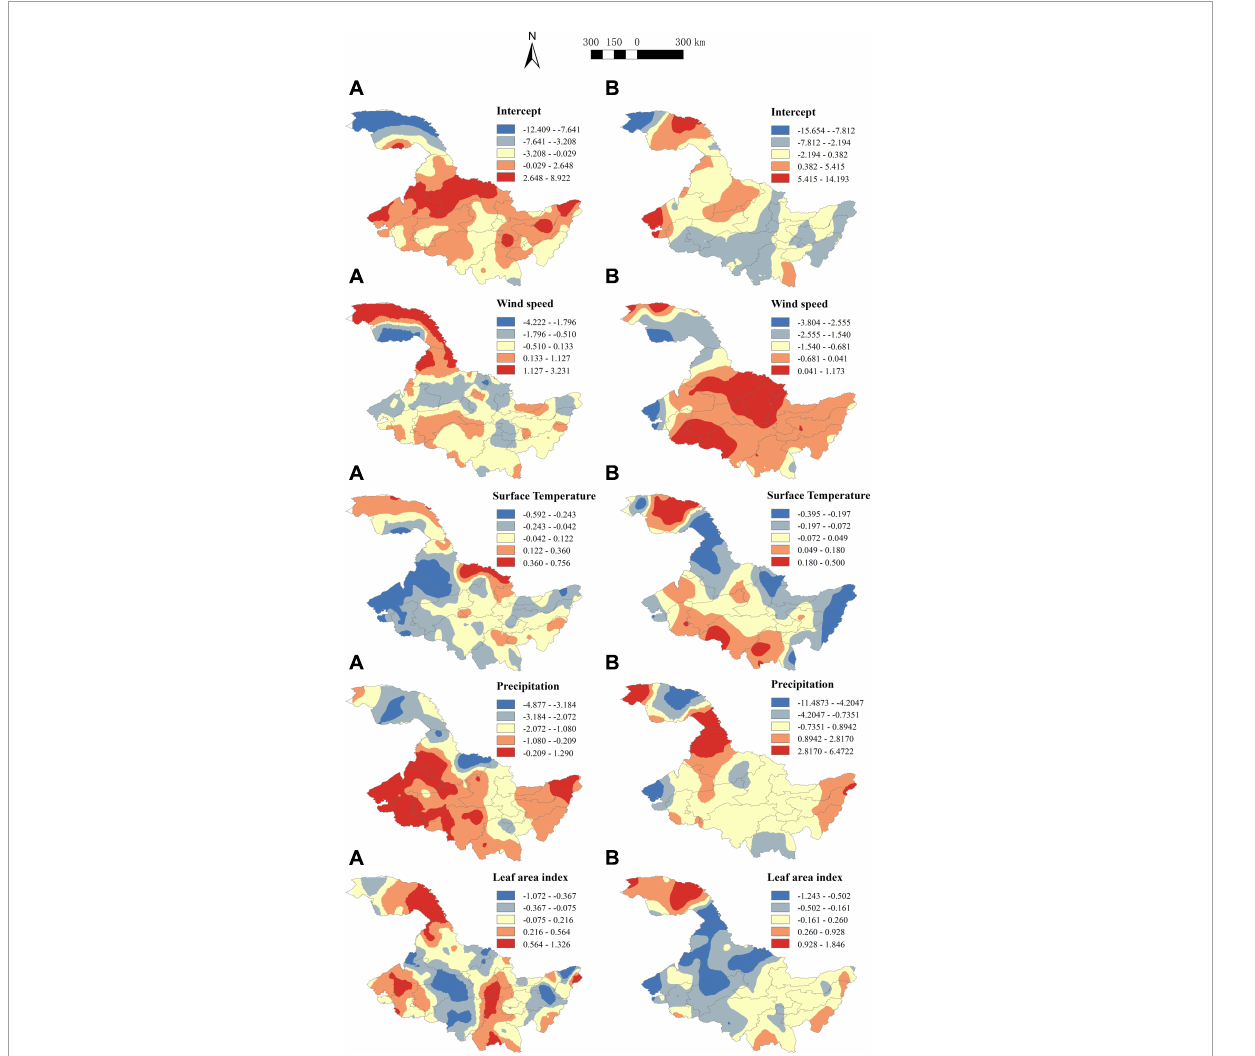
FIGURE3 Parameter distribution for each variable of the geographically weighted logistic regression (GWLR) model. (A) Parameter distribution in spring fire prevention period. (B) Parameter distribution in autumn fire prevention